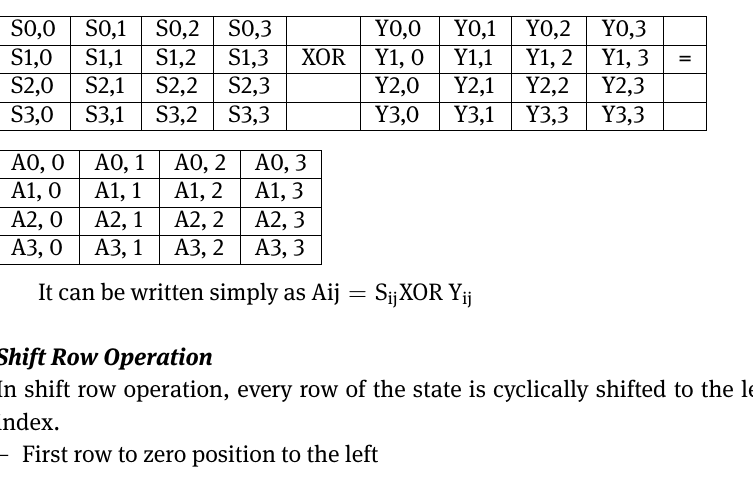
Table 1: Rounds for corresponding key